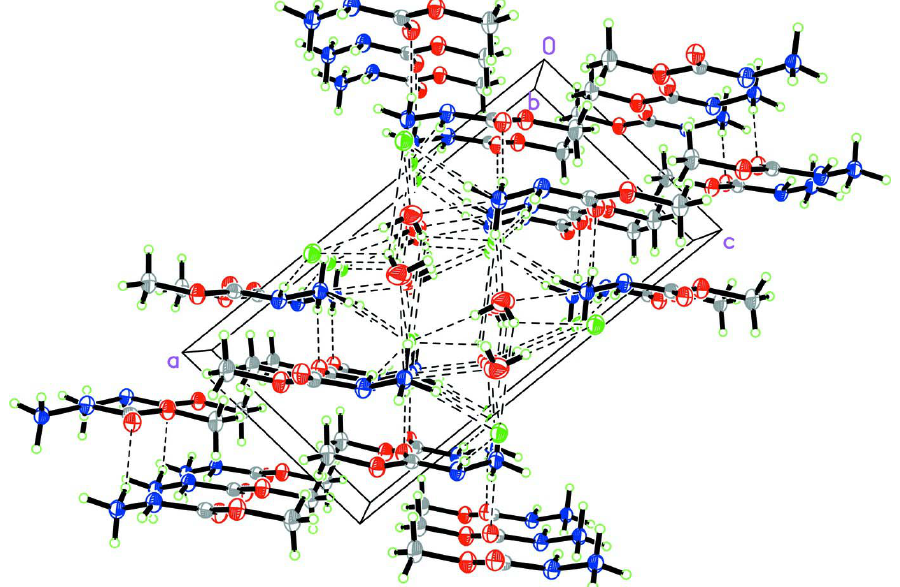
Figure 2 The crystal packing of the title compound, viewed approximately along the c axis. Hydrogen bonds are shown as dashed